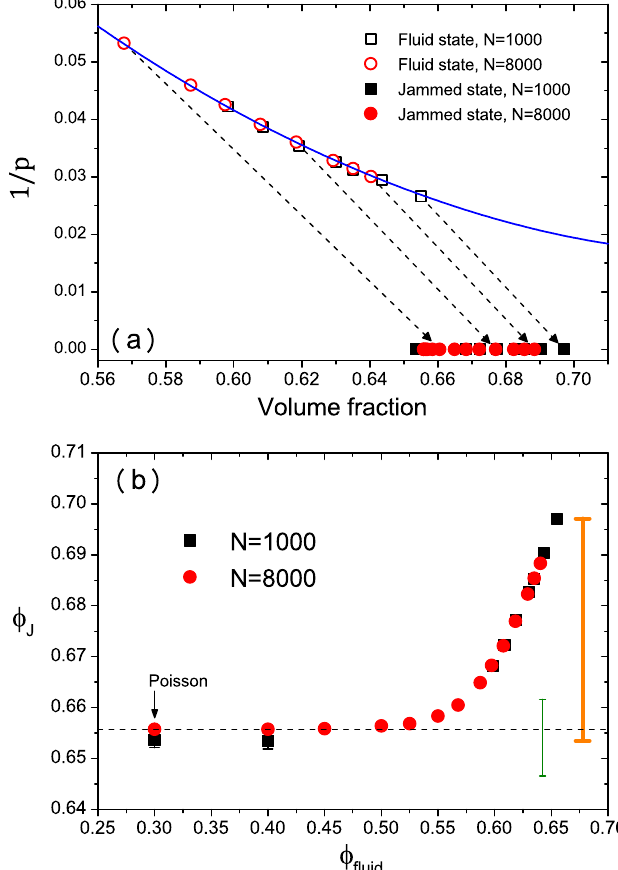
Figure 1: (a) Equation of state of the system for two different system sizes. Equilibrium fluid states are shown as empty points. A modified version of the Carnahan-Starling equation of state for polydisperse systems is drawn as a solid line [ 64 ] . Jammed states (filled points) ob- tained by the compression algorithm are located at p → ∞ . The dashed arrows connect an equilibrium parent fluid state to the corresponding jammed state. (b) Evolution of the aver- aged jamming transition volume fraction φ obtained by the compression from an equilibrium J parent fluid with volume fraction φ . We also report φ starting from a Poisson distributed fluid J = 0.3. The horizontal dashed line is φ configuration with φ generated from a Poisson fluid J distribution for N = 8000. The vertical bars correspond to the width of the J-line for this work (thick bar) which is about 3 times larger than previous works using a binary mixture [ 31 ] (thin